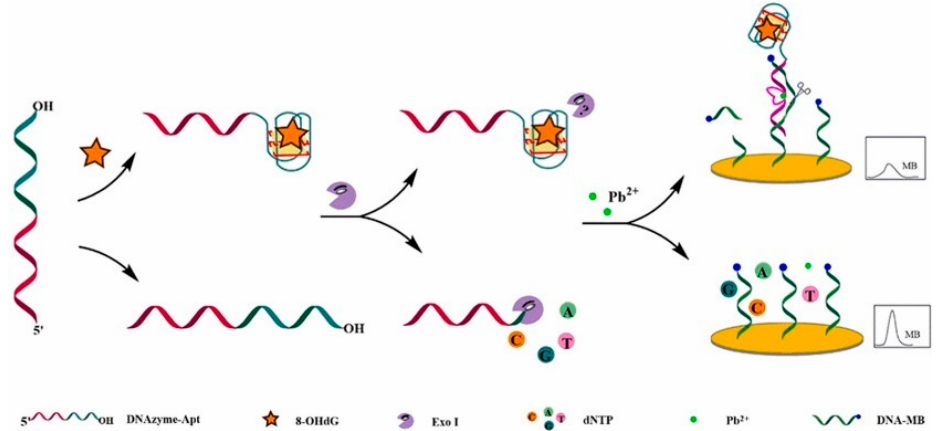
Figure 5. A o 8 dGuo-specific aptamer construct. Reprinted with permission from Reference [33]. © 20019, Elsevier.